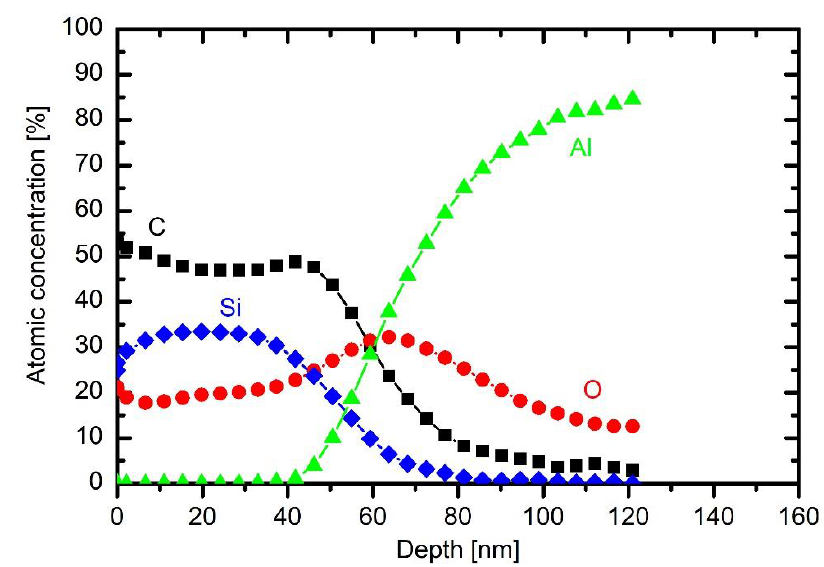
Figure 8. XPS depth profile of a sample exposed to plasma of 10 Pa HMDSO for 30 s at 200 W.